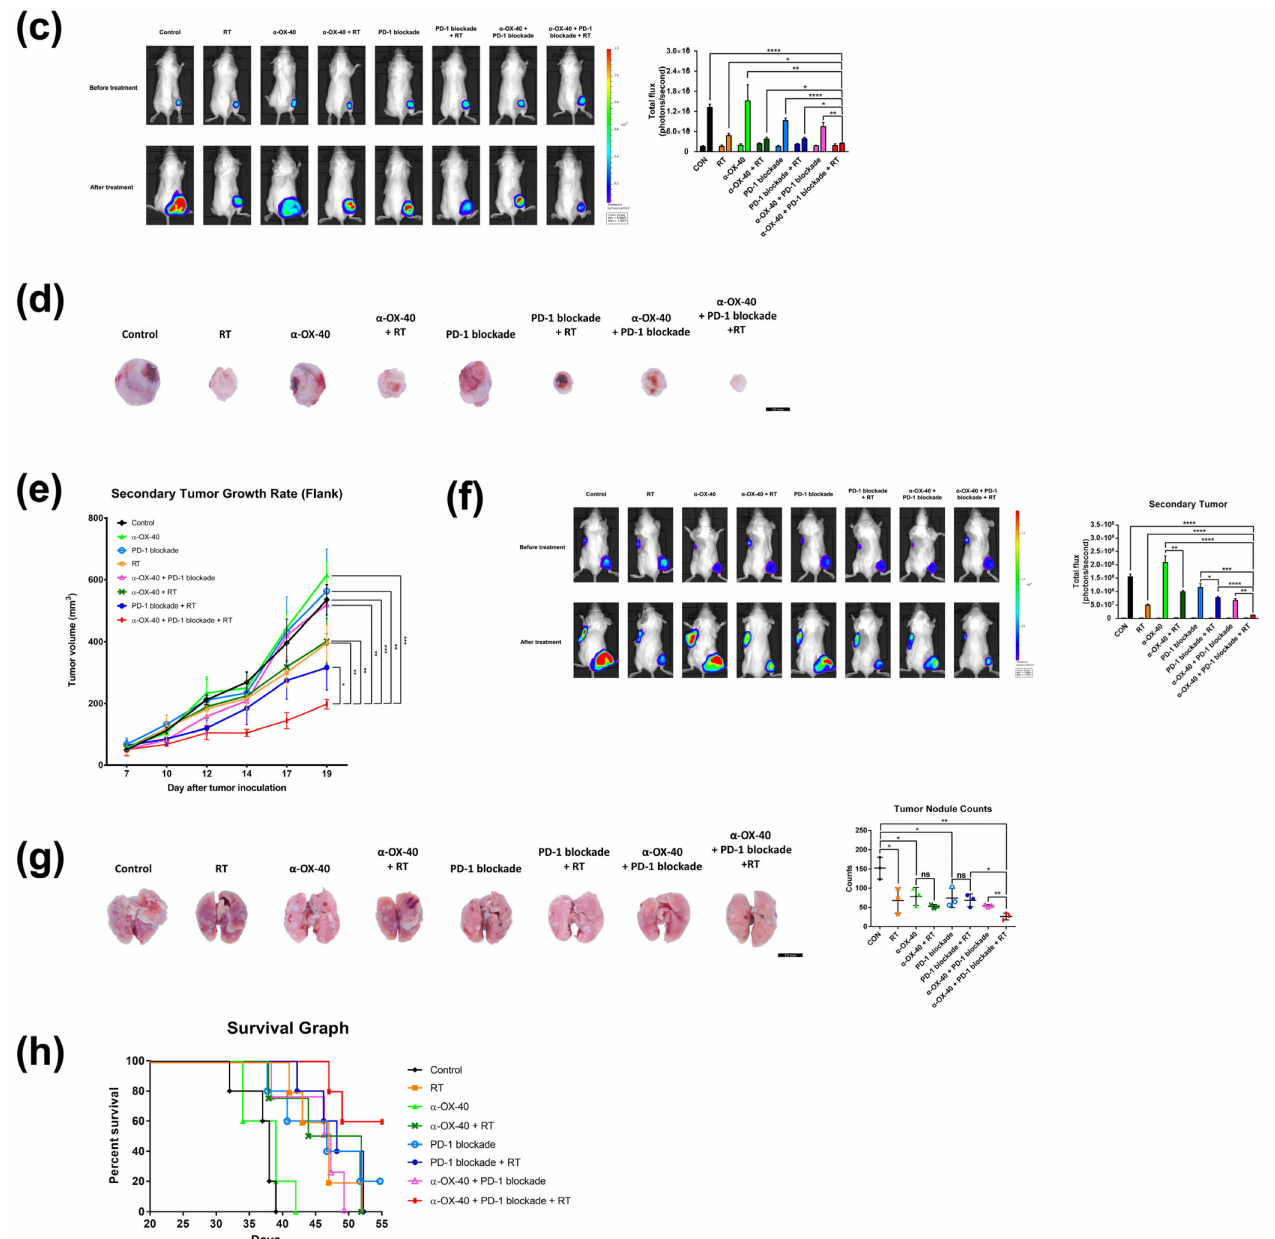
Figure 1. Combination of RT, α -OX40, and PD-1B increases primary and abscopal tumor con- trol and prolongs survival. Primary tumor growth curves of subcutaneous ( a ) luciferase-tagged and ( b ) luciferase-untagged 4T1 implants in mice for each group: control, RT, α -OX40, PD-1B, α -OX40 + RT, PD-1B + RT, α -OX40 + PD-1B, and triple combination therapy (each group, n = 5). ( c ) Representative bioluminescence images of 4T1-luc tumor-bearing mice acquired before and after each treatment. Paired bar graphs comparing primary tumor volumes before and after treatment show total luminosity flux (emitted photons per second) for each group. ( d ) Images of extracted tumors from luciferase-untagged 4T1 tumor-bearing mice. ( e ) Secondary (abscopal) tumor growth curves in luciferase-untagged 4T1 tumor-bearing mice for each group (each group, n = 5). ( f ) Quanti- tation and representative bioluminescence images of 4T1-luc secondary tumor-bearing mice acquired before and after each treatment. ( g ) Metastatic lung nodules observed on post-implantation day 31. ( h ) Survival curves of 4T1-luc tumor-bearing mice for each treatment group (each group, n = 5). * p < 0.05, ** p < 0.01, *** p < 0.001, **** p < 0.0001. Abbreviations: 4T1-luc, luciferase-tagged 4T1; CON, control; RT,